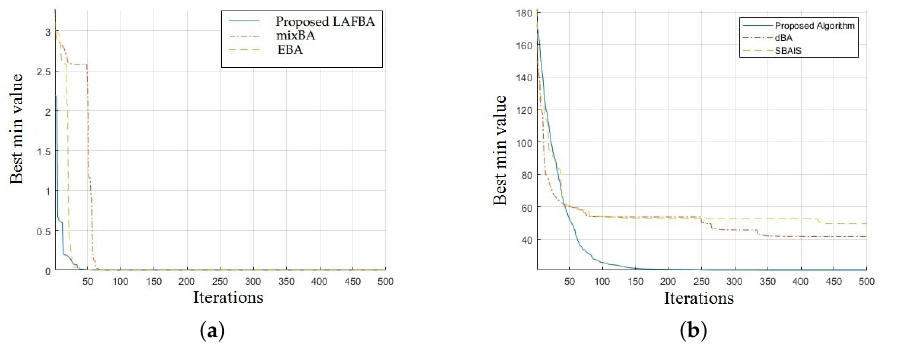
Figure 3. ( a ) Trid function convergence graph. ( b ) Rastrigin function convergence graph.